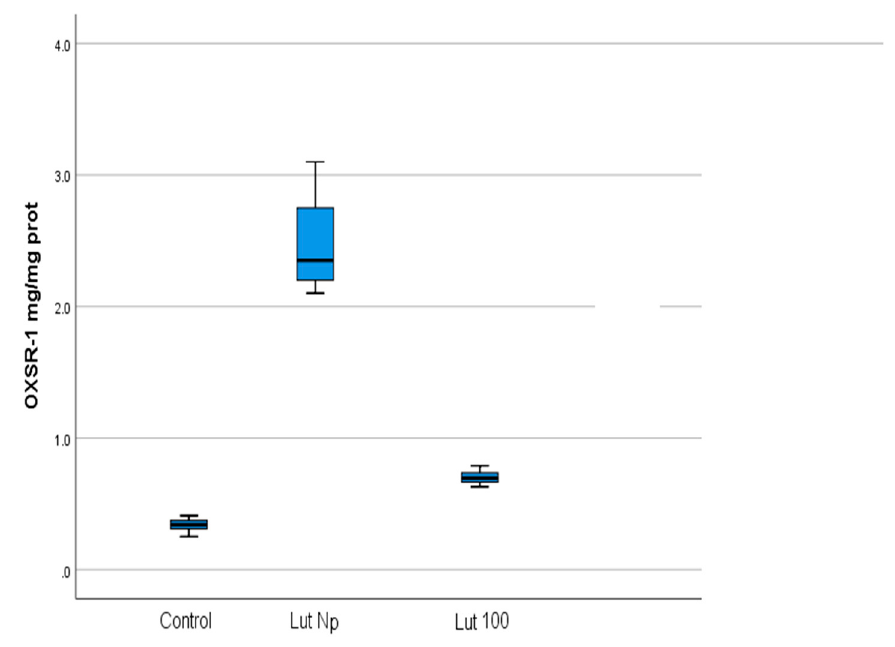
Figure 4. Comparison of OXSR-1 (mg/mg protein) values with regard to the batches of the studied OSSC cell lines (Lut 100—oral cancer squamous cells incubated with lutein (100 mg); Lut Nps— oral cancer squamous cells incubated with lutein nanoparticles; CR—control oral cancer squamous cells). Table 4. Comparison of post hoc TAC results (ng/mg protein) with regard to the batch of the